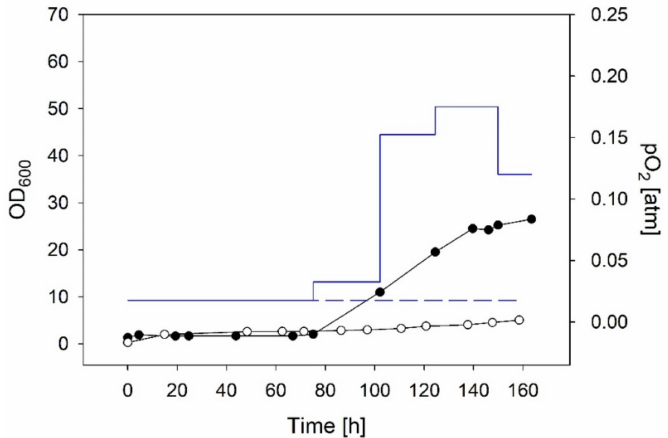
Figure 6. Time curves of gas cultivations with constant gas flow and stepwise increased p O2 . Circles indicate OD 600 values, blue lines p O2 (constant gas flow white circles and dashed line; stepwise increased p O2 black circles and full